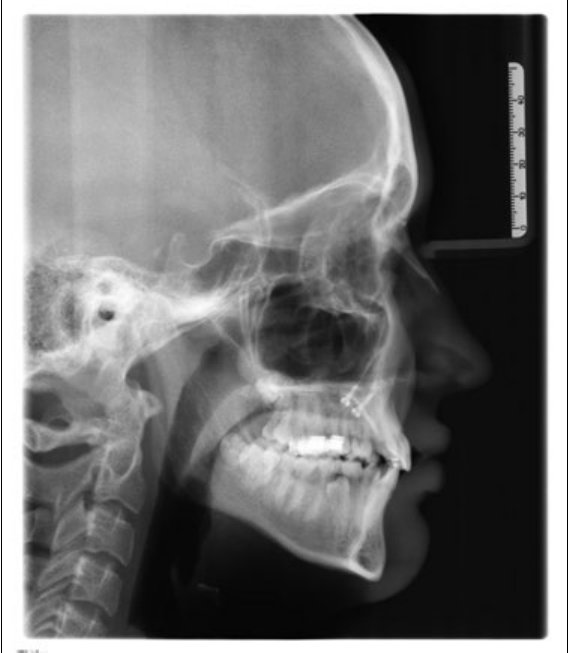
Figure 6. Pretreatment lateral